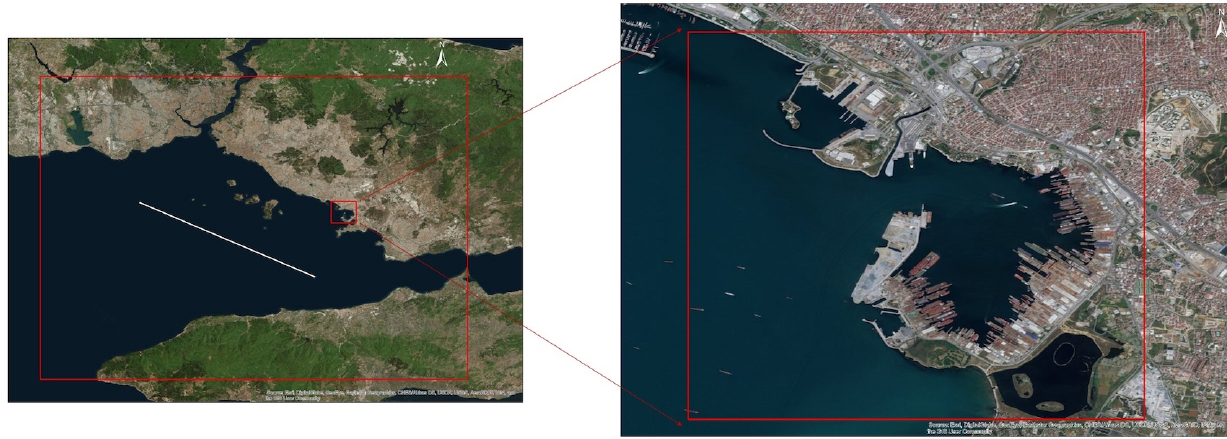
Figure 2. The Marmara Sea region, Tuzla test site, and the location of the PIF segment which is used in the analysis like a straight line (created using ArcMap version